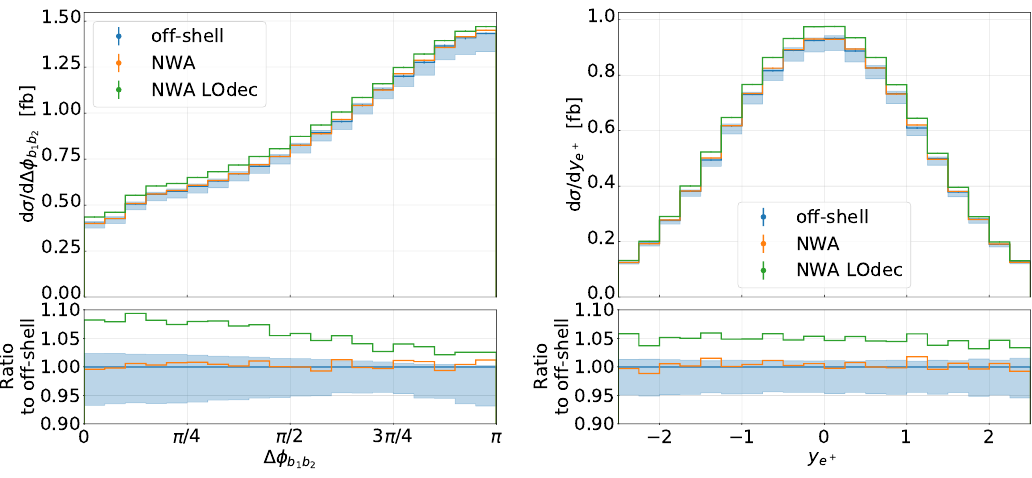
Figure 13 . Differential distributions at NLO QCD for the observables ∆ φ b pp → e + ν e µ − ¯ ν µ b ¯ b H process at the LHC with